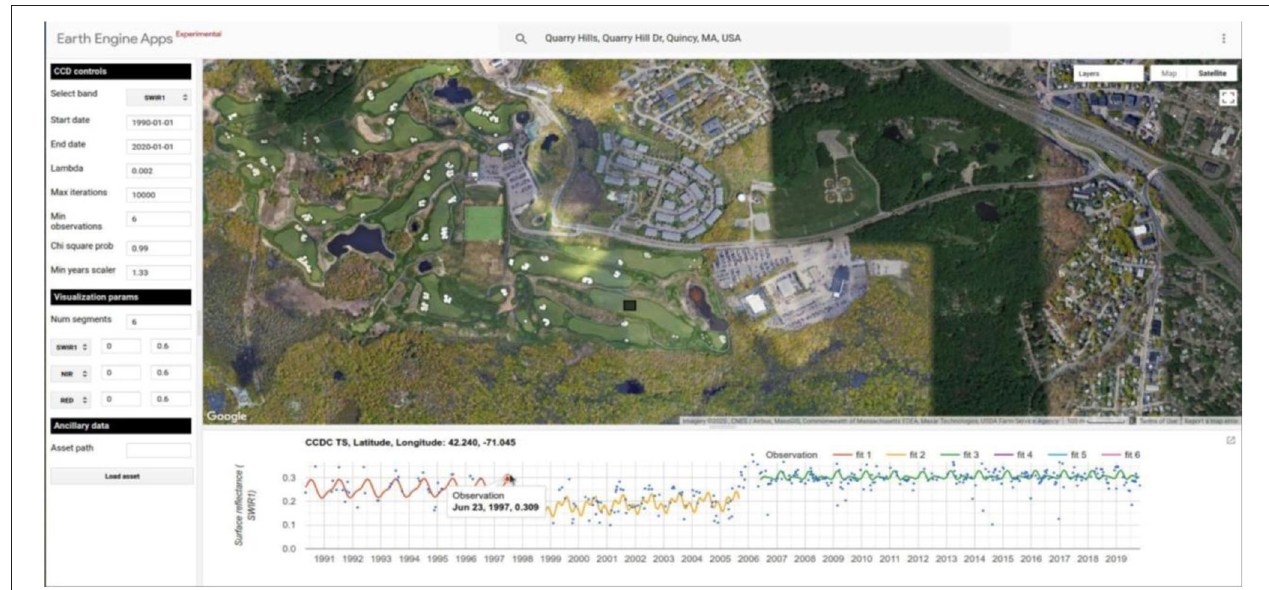
FIGURE 8 | Landsat time series showing the transformation from landfill to golf course. Hovering on the observations with the pointer shows their date and corresponding value. Clicking on them will load the corresponding Landsat image, using the visualization parameters for Red-Green-Blue (RGB) composite in the left